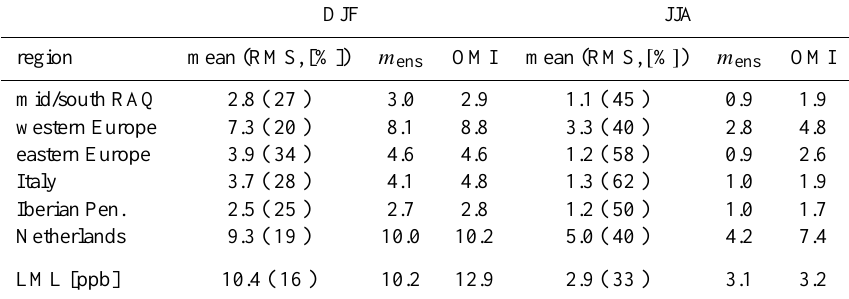
Table 4. Seasonal and regional area mean from all RAQ models, and in brackets its RMS, scaled to the mean of all RAQ models, as well as the corresponding mean of the ensemble median and the OMI observations, for DJF and JJA in units 10 15 molec/cm 2 . In the bottom line the mean (and RMS) surface concentrations of all RAQ models is provided in ppb, compared to LML observations for DJF and JA. DJF JJA region mean (RMS, [%]) m ens OMI mean (RMS, [ % ] ) m ens OMI mid/south RAQ 2.8 ( 27